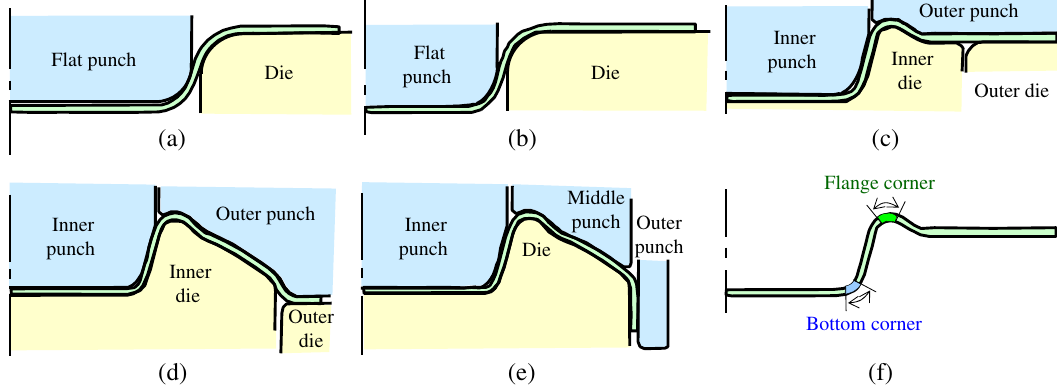
Figure 1. Stamping process of wheel disk: (a) 1st stage, (b) 2nd stage, (c) 3rd stage, (d) 4th stage, (e) 5th stage and (f) bottom and flange corners in cup with flange formed by three-stage stamping.